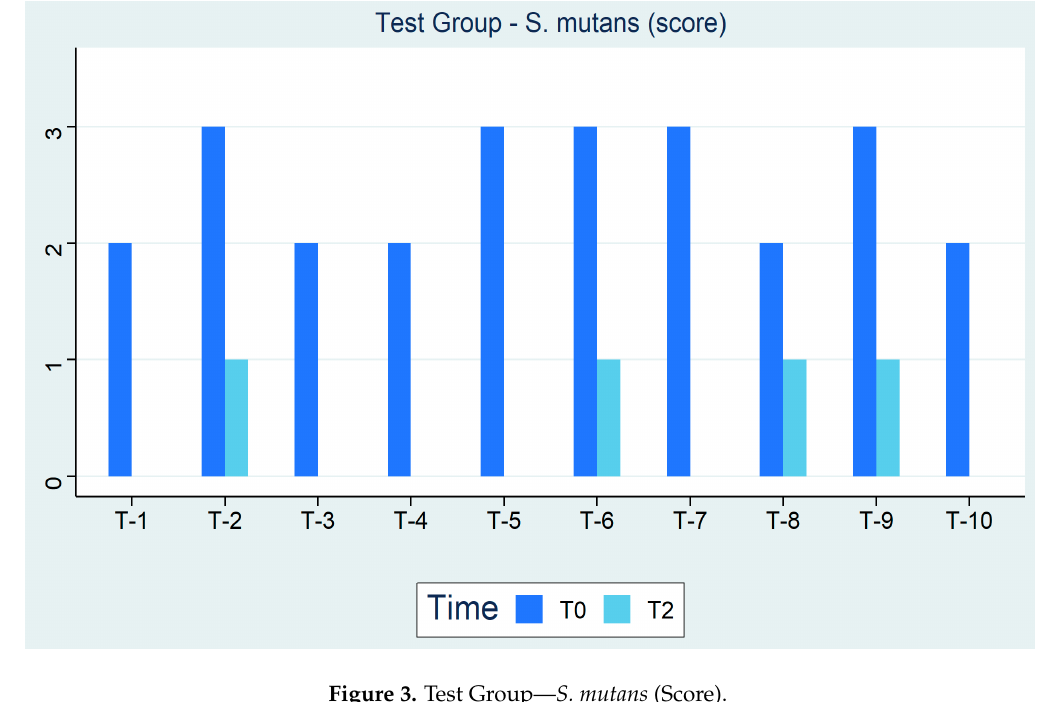
Figure 3. Test Group— S. mutans (Score).